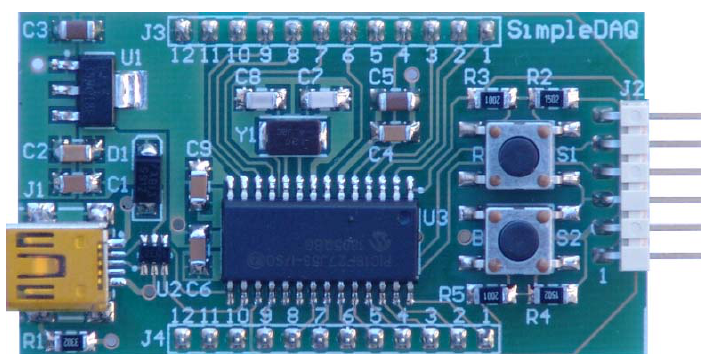
Figure 2. SimpleDAQ